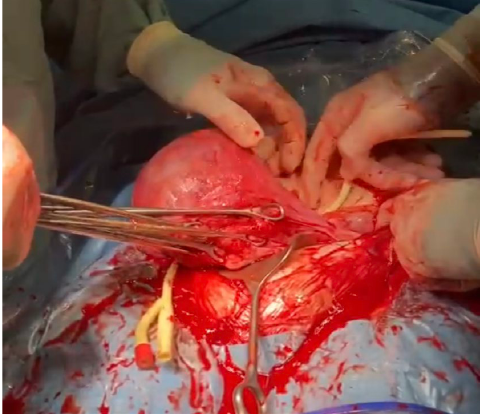
Figure 9. Placement of a Foley catheter as a tourniquet to prevent hemorrhage.